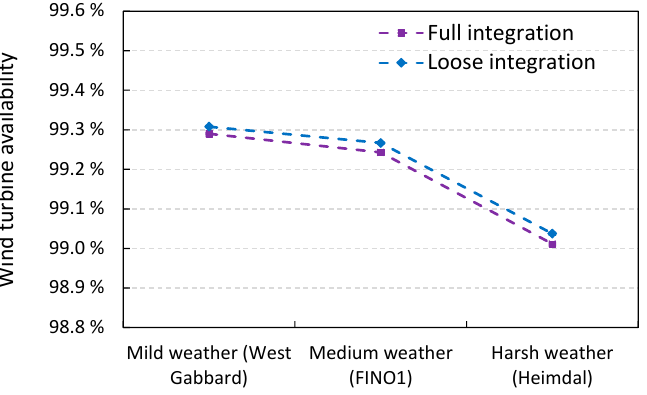
Figure 6. Results for average time-based wind turbine availability under different weather conditions.